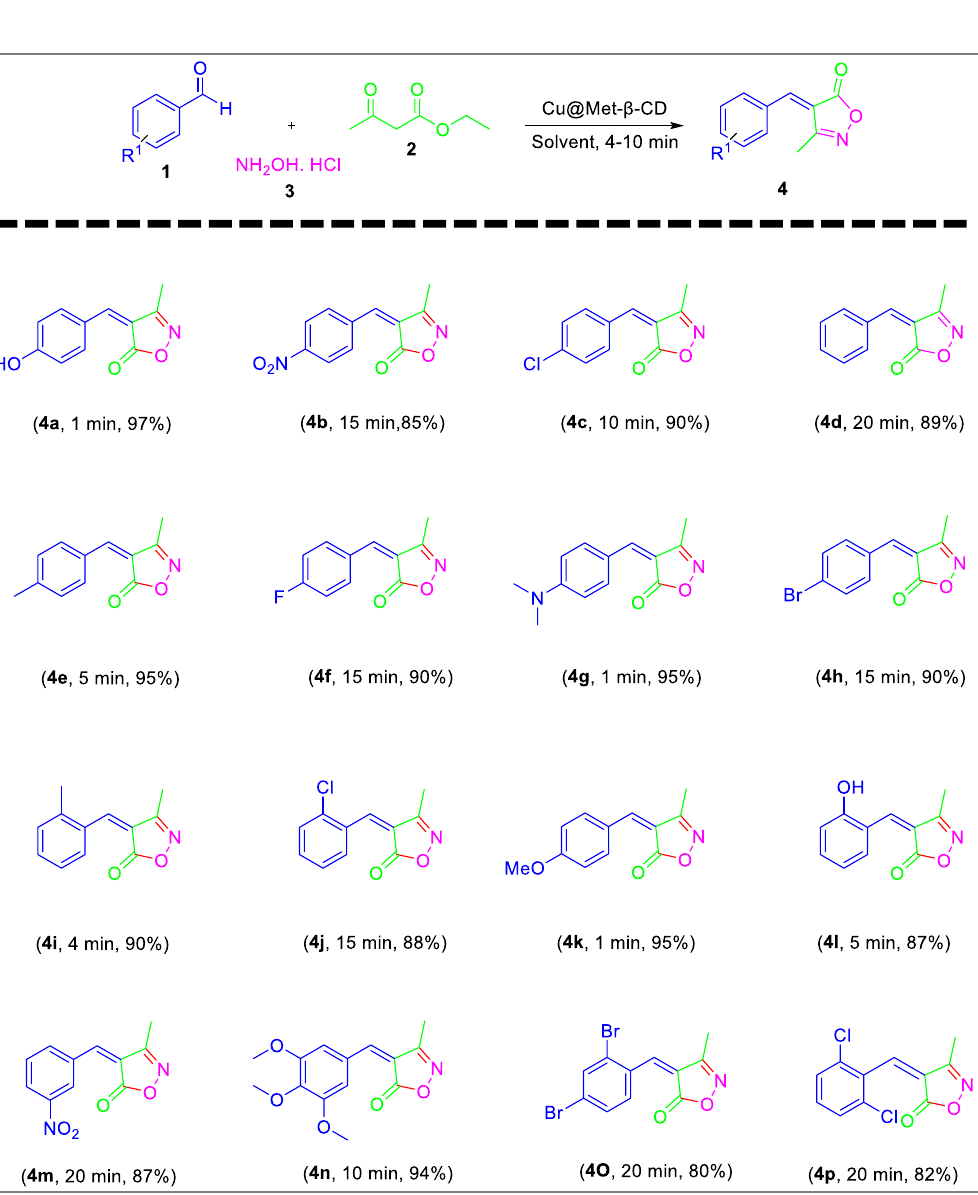
Table 3. Preparation of 3-methyl-4-arylmethylene-isoxazole-5(4H)-ones in the presence of Cu@Met-β ‐ CD as a green